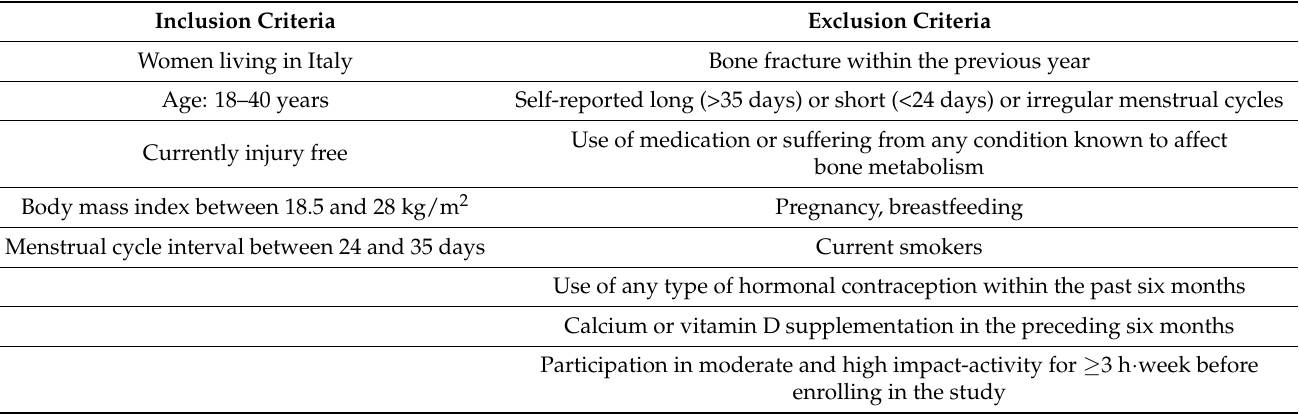
Table 1. Inclusion and exclusion criteria of the